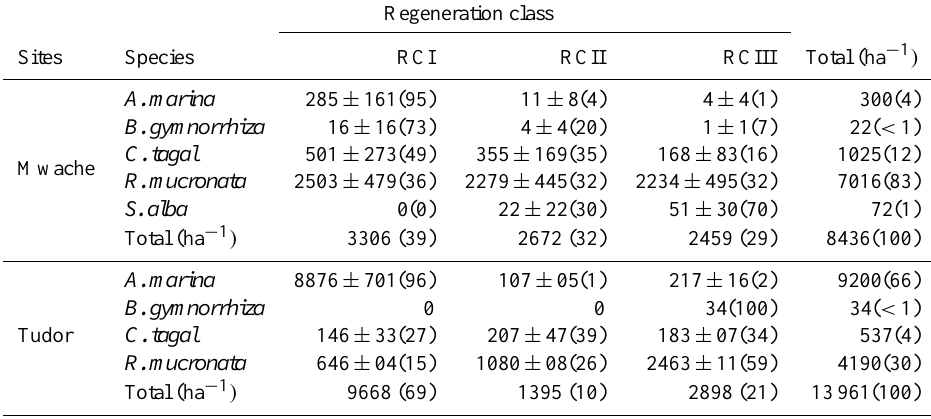
Table 2. Juvenile density in forests within the study area.